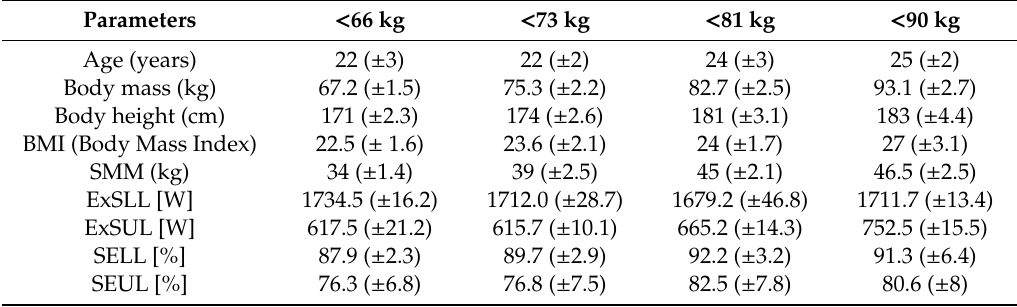
Table 1. Descriptive statistics of characteristics variables for the 4 weight categories of judokas (mean and